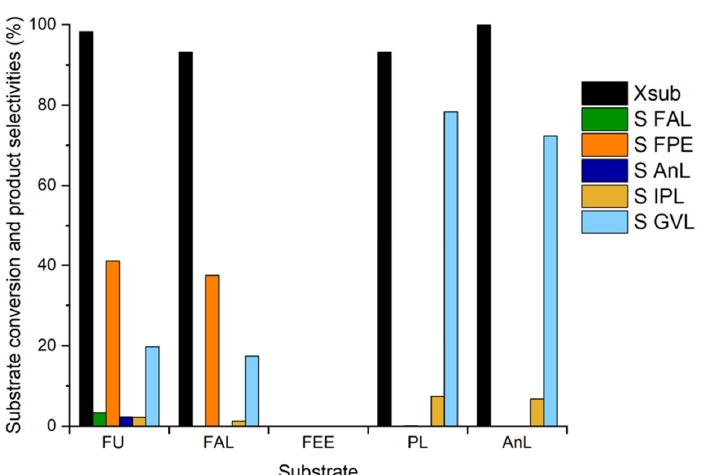
Figure 11. Comparison between substrate conversion and product selectivity trends obtained using the principal intermediates as substrates for the production of γ‐ valerolactone on Ti/Zr/O (1:1). Reaction conditions: [substrate] = 67 mM; τ = 10 min, T = 180 °C, m cat = 0.76 g.